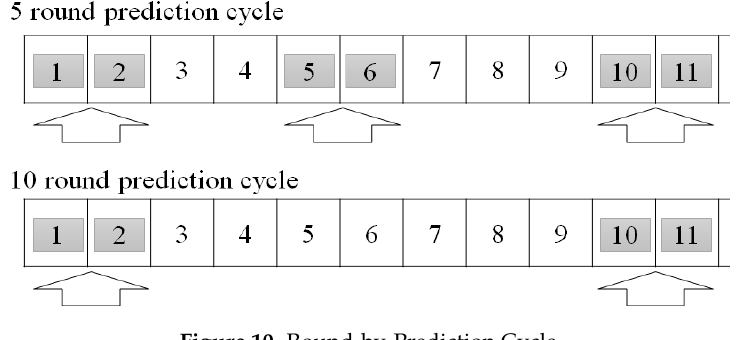
Figure 10. Round-by-Prediction Cycle.